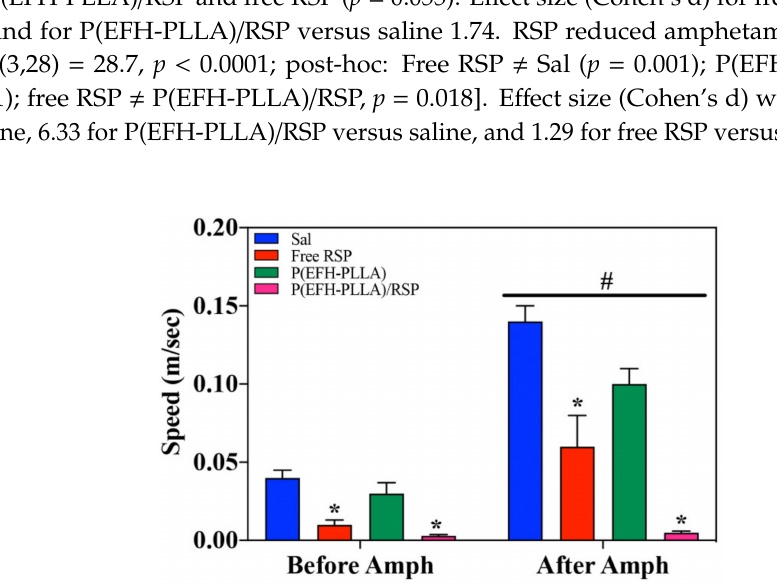
Figure 8. Mean speed analysis using ANOVA of open field test with hollow and drug-loaded NPs treated 0–30 min prior to amphetamine administration and 30–60 min post amphetamine uptake. Asterisks (*) denote statistical significance versus saline and the hashtag (#) signifies the e ff ect of amphetamine